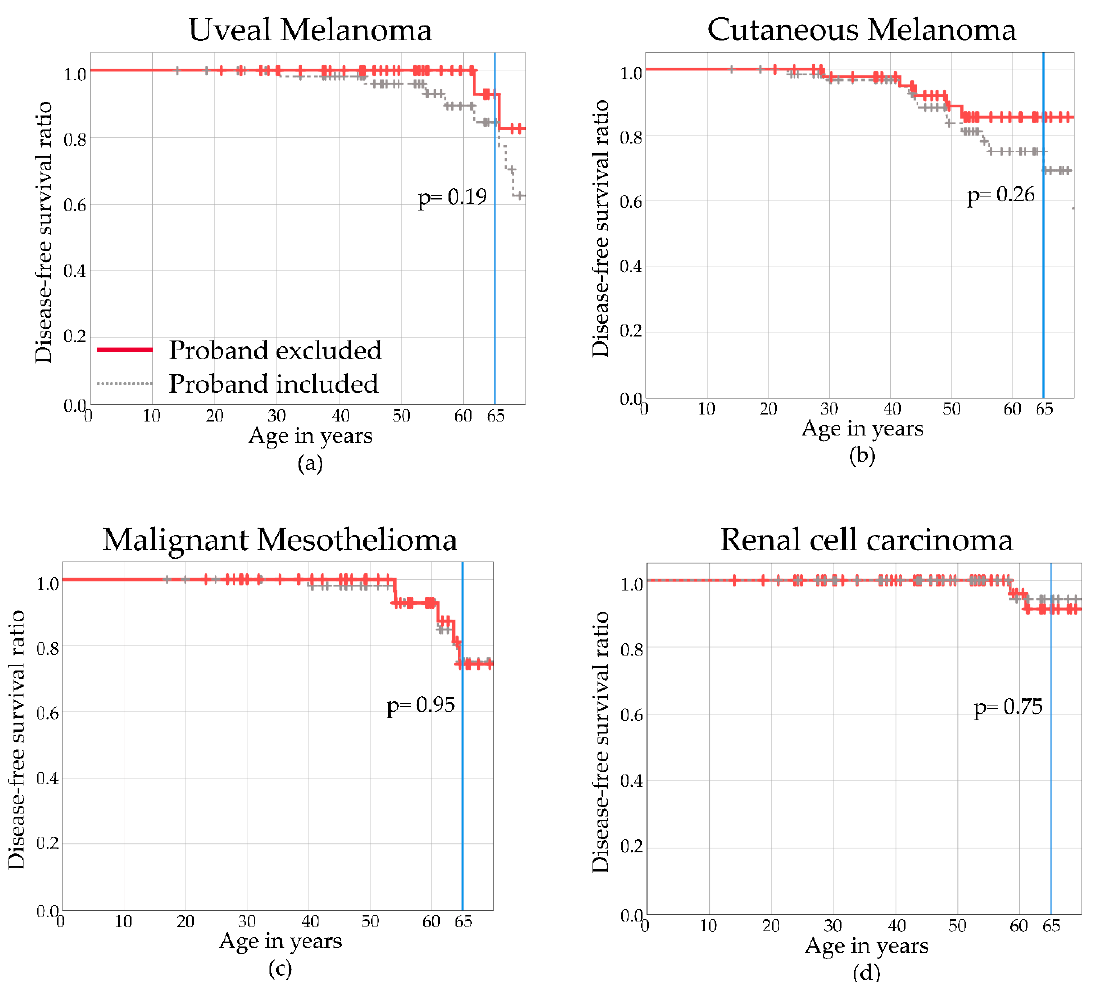
Figure 2. Disease-free Kaplan–Meier curves for proven / obligate non-proband BAP1 variant carriers excluding probands (red) of uveal melanoma ( a ), cutaneous melanoma ( b ), malignant mesothelioma ( c ), and renal cell carcinoma ( d ). Individuals with BAP1-TPDS including probands are illustrated with the gray dotted line.